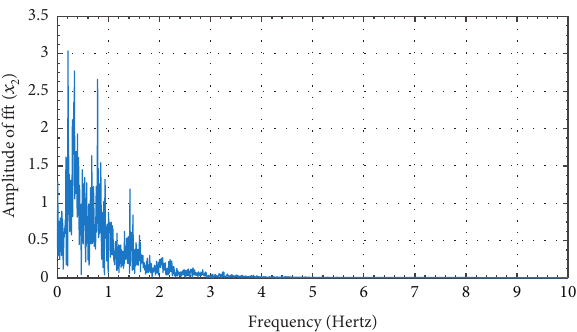
Figure 12: Amplitude versus frequencies of x